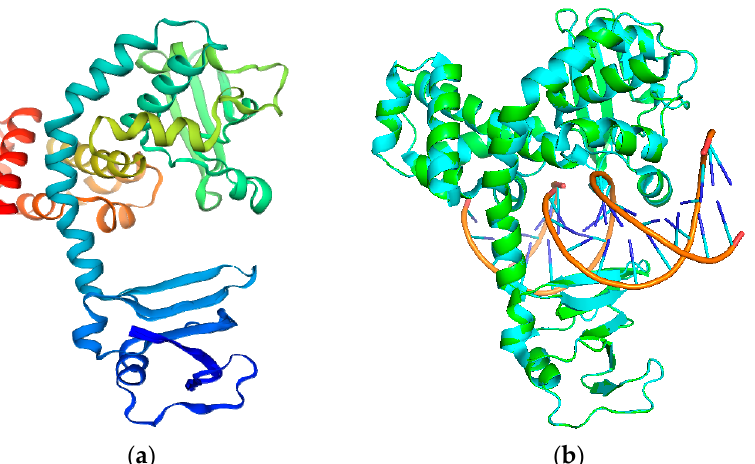
Figure 1. ( a ) Cartoon views of predicted 3D structures of the TOP1 from the SWISS-MODEL; ( b ) the structural alignment between the modeled TOP1 and template TOP1 (PDB ID 3IGC) from the variola virus (green—modeled TOP1; cyan—template TOP1).